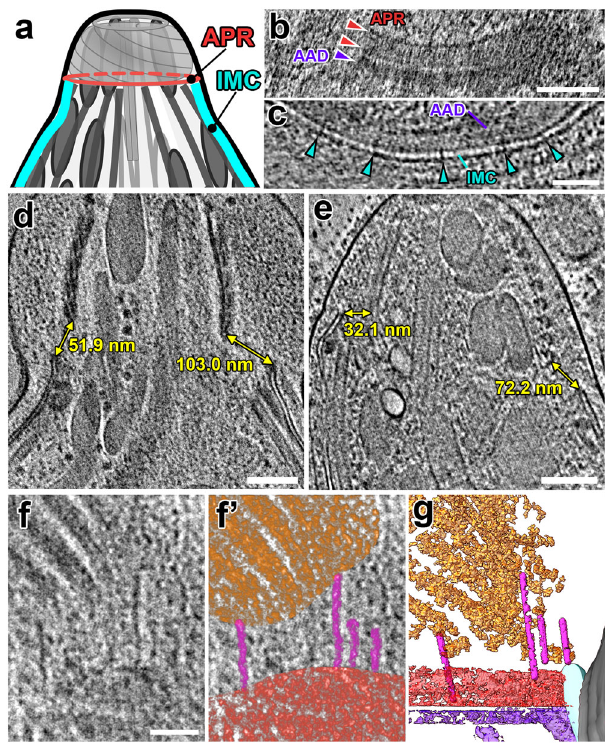
Fig. 2 | The protruded conoid is tilted and off-center relative to the APRs. a Cartoon of the apical complex in the protruded state, highlighting the APR and IMCstructures. b Atomographicslice(longitudinalorientation)showstwodistinct APR rings (red arrowheads) and the AADring (purple arrowhead),which islocated between the APR and IMC. c A cross-sectional tomographic slice shows the IMC near the apical edge with “ spacer ” densities (cyan arrowheads) between the two membranes. d , e Tomographic slices through the protruded conoidcomplex from two parasites. Measurements mark the minimum distances between the IMC and the conoid fi bers on each side of the conoid. f , g Tomographic slice ( f : original; f ’ : pseudo-colored) and 3D-segmented isosurface rendering ( g ) of the same region at the base of a protruded conoid show fi lamentous actin-like densities (magenta) connectingbetweentheconoid(orange)andtheAPRs(red).Scalebars:100nm(in b , d , e ); 50nm (in c , f